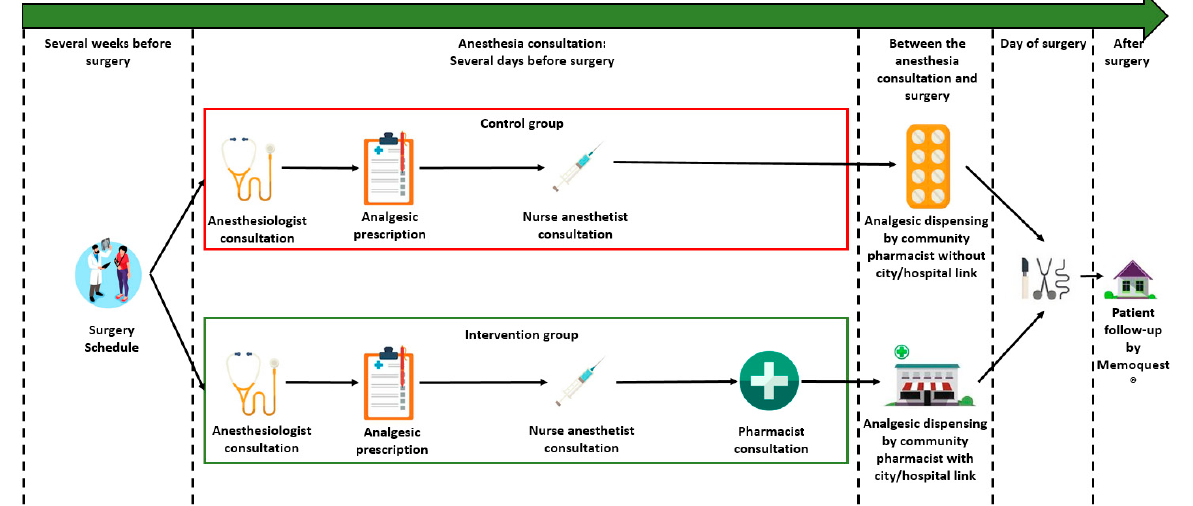
Figure 1. Care pathway in the control group and intervention group .